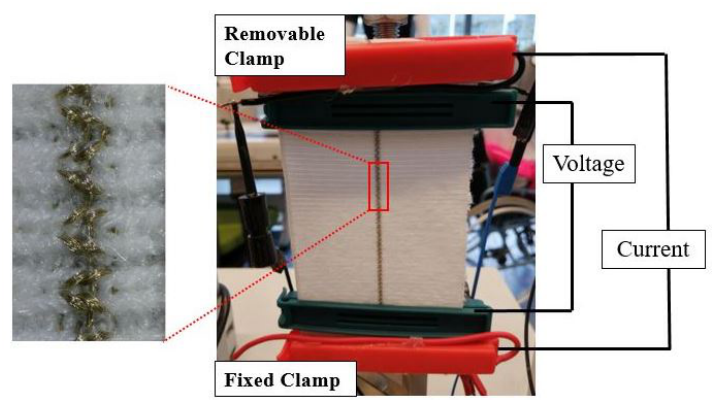
Figure 2. Test setup with an attached knitted strain sensor and four-point probe connections.